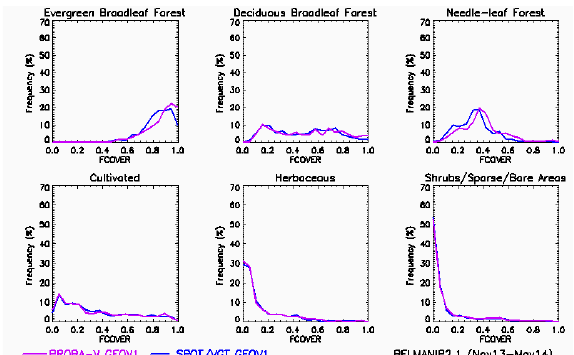
Figure 6: Distribution of FCover values of each product for the BELMANIP2.1 sites during Nov13-May14 period for each biome type.